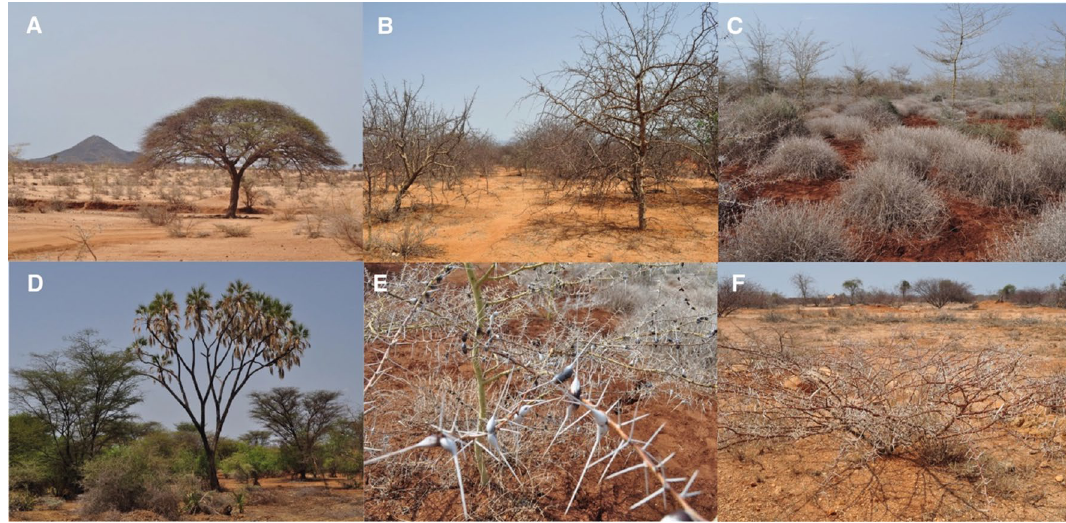
Figure 3. Examples of xerophytic shrubland environments in modern eastern Africa, including typical species (sp.). ( A ) Acacia tortilis ( B ) Commiphora sp. ( C ) Acacia sp. and Duosperma eremophilum. ( D ) Hyphaene compressa , Acacia sp., Salvadora persica , Cyperacea and Lawsonia inermis ( E ) Acacia sp. and Duosperma eremophilum , ( F ) Acacia tortilis (background: Commiphora sp. Capparaceae sp . Tephrosia sp . and Indigofera spinosa